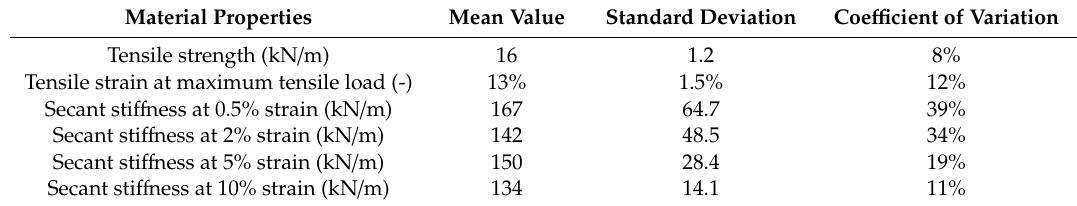
Table 5. Mechanical properties of the tested polypropylene geogrid [38].